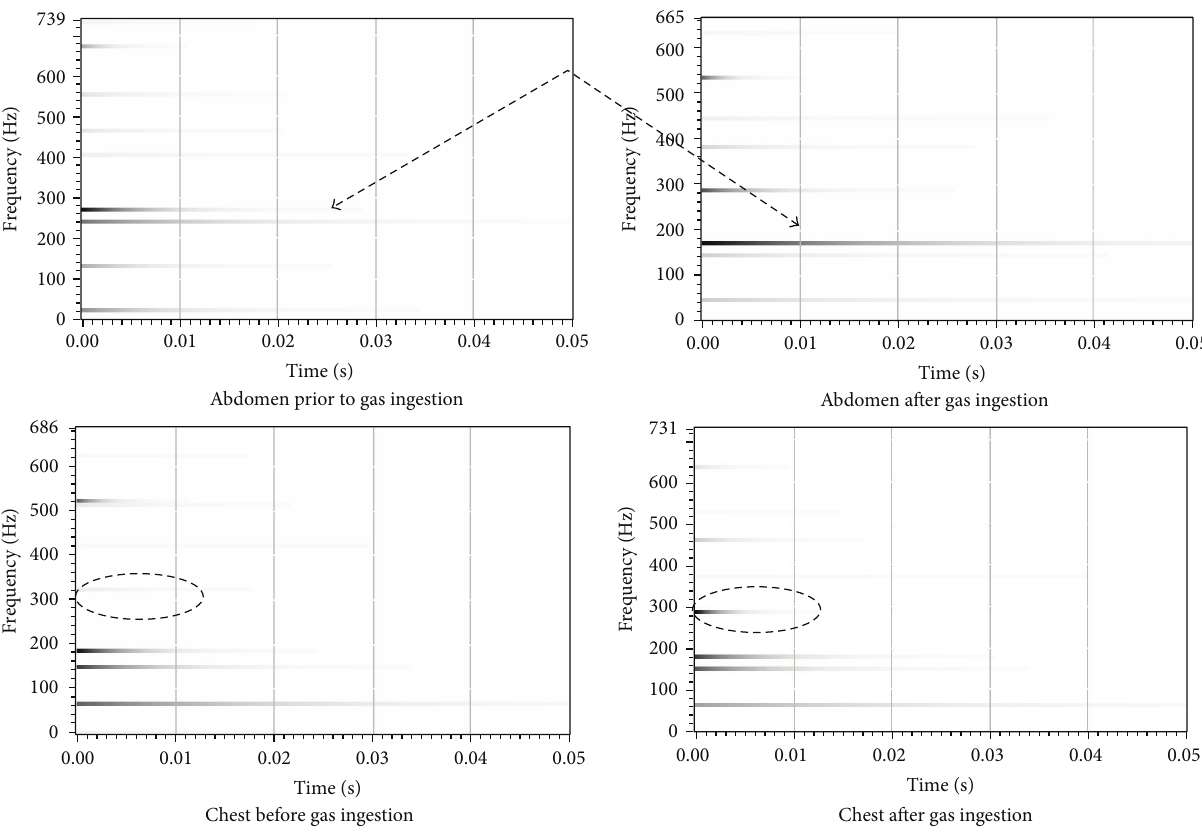
Figure 5: MPM TFR of percussion signals from a normal volunteer before and after intake of a carbonated drink. The percussion signals were recorded both over the abdomen and the